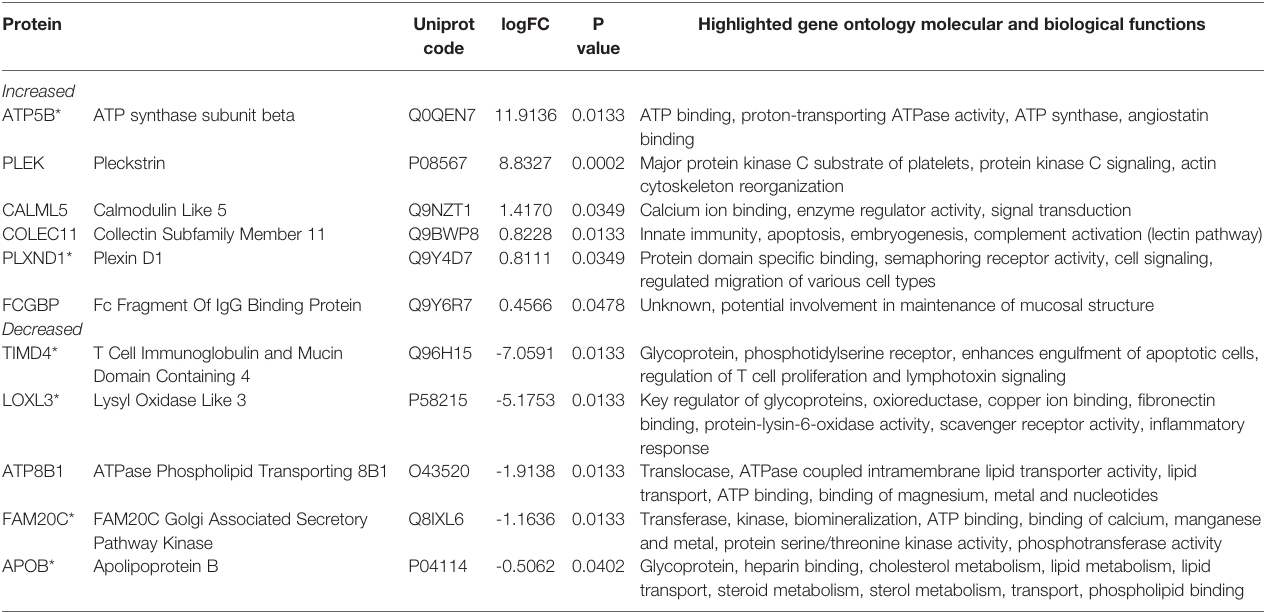
TABLE 2 | Signi fi cantly altered proteins in bvFTD-autoimmune compared to bvFTD-nonautoimmune serum. Protein P